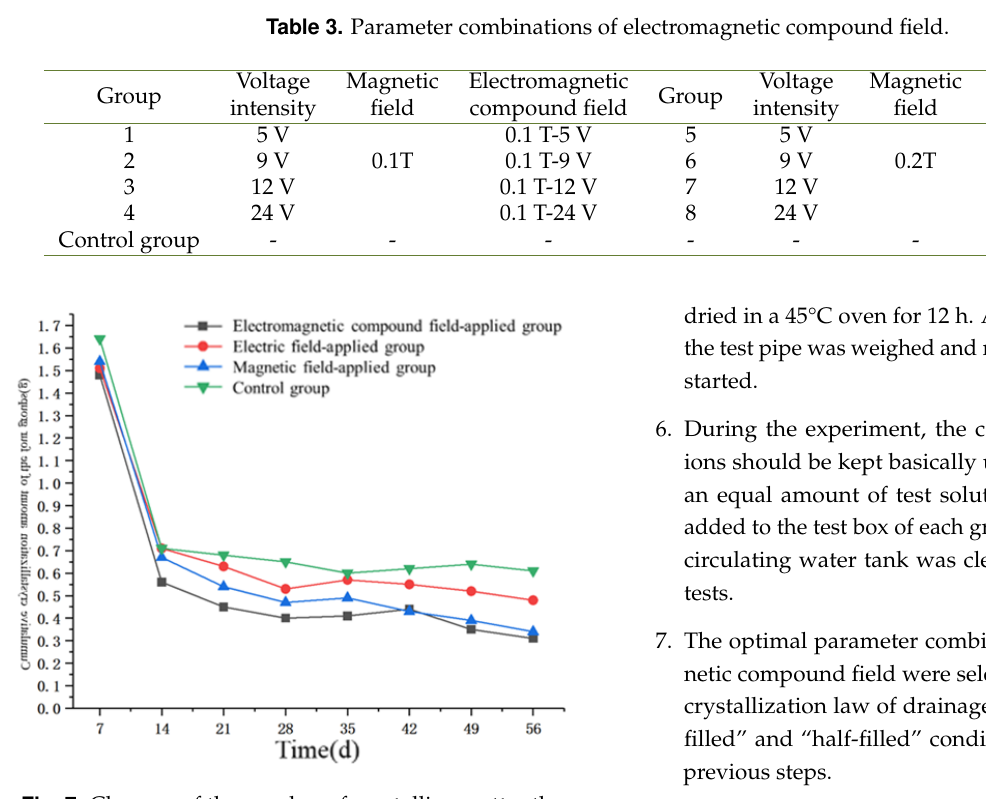
Fig. 7. Changes of the number of crystalline matter the four groups per cycle over